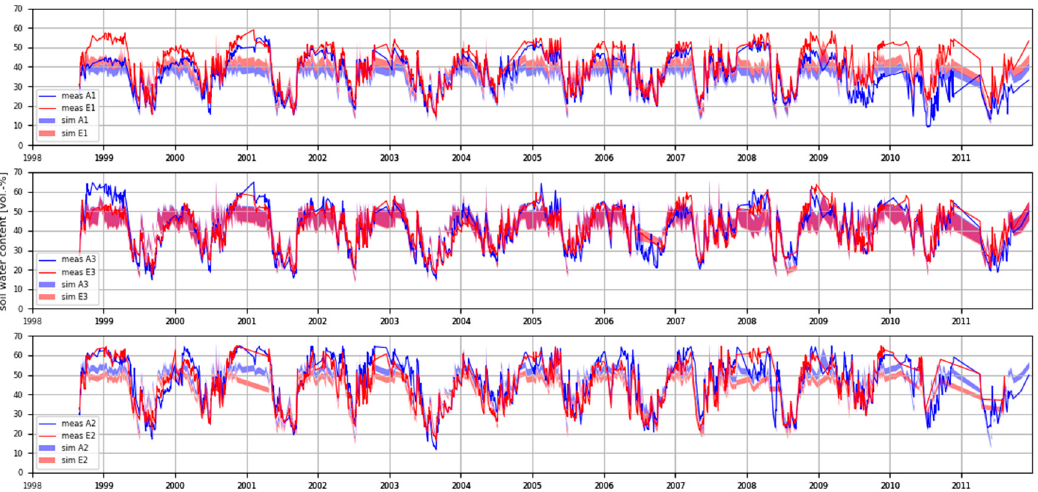
Figure 2. Time series of soil water content in 0–15 cm soil depths from ambient (aCO 2 ) and elevated CO 2 (eCO 2 ) FACE rings. Plots are arranged according to increasing soil moisture from driest (top, A1/E1) to medium (middle, A3/E3) and wettest (bottom, A2/E2) rings. Measurements are depicted in lines, and confidence intervals of simulations are depicted as colored areas.